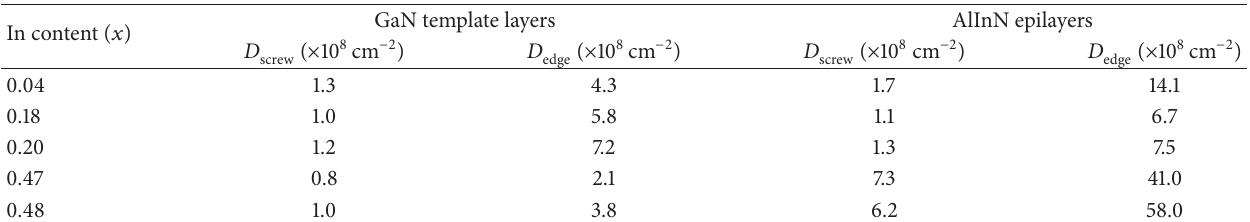
Table 2: The measured edge and screw type dislocations densities in GaN template layers and the AlInN epilayers are listed. GaN template In content ( 𝑥 )